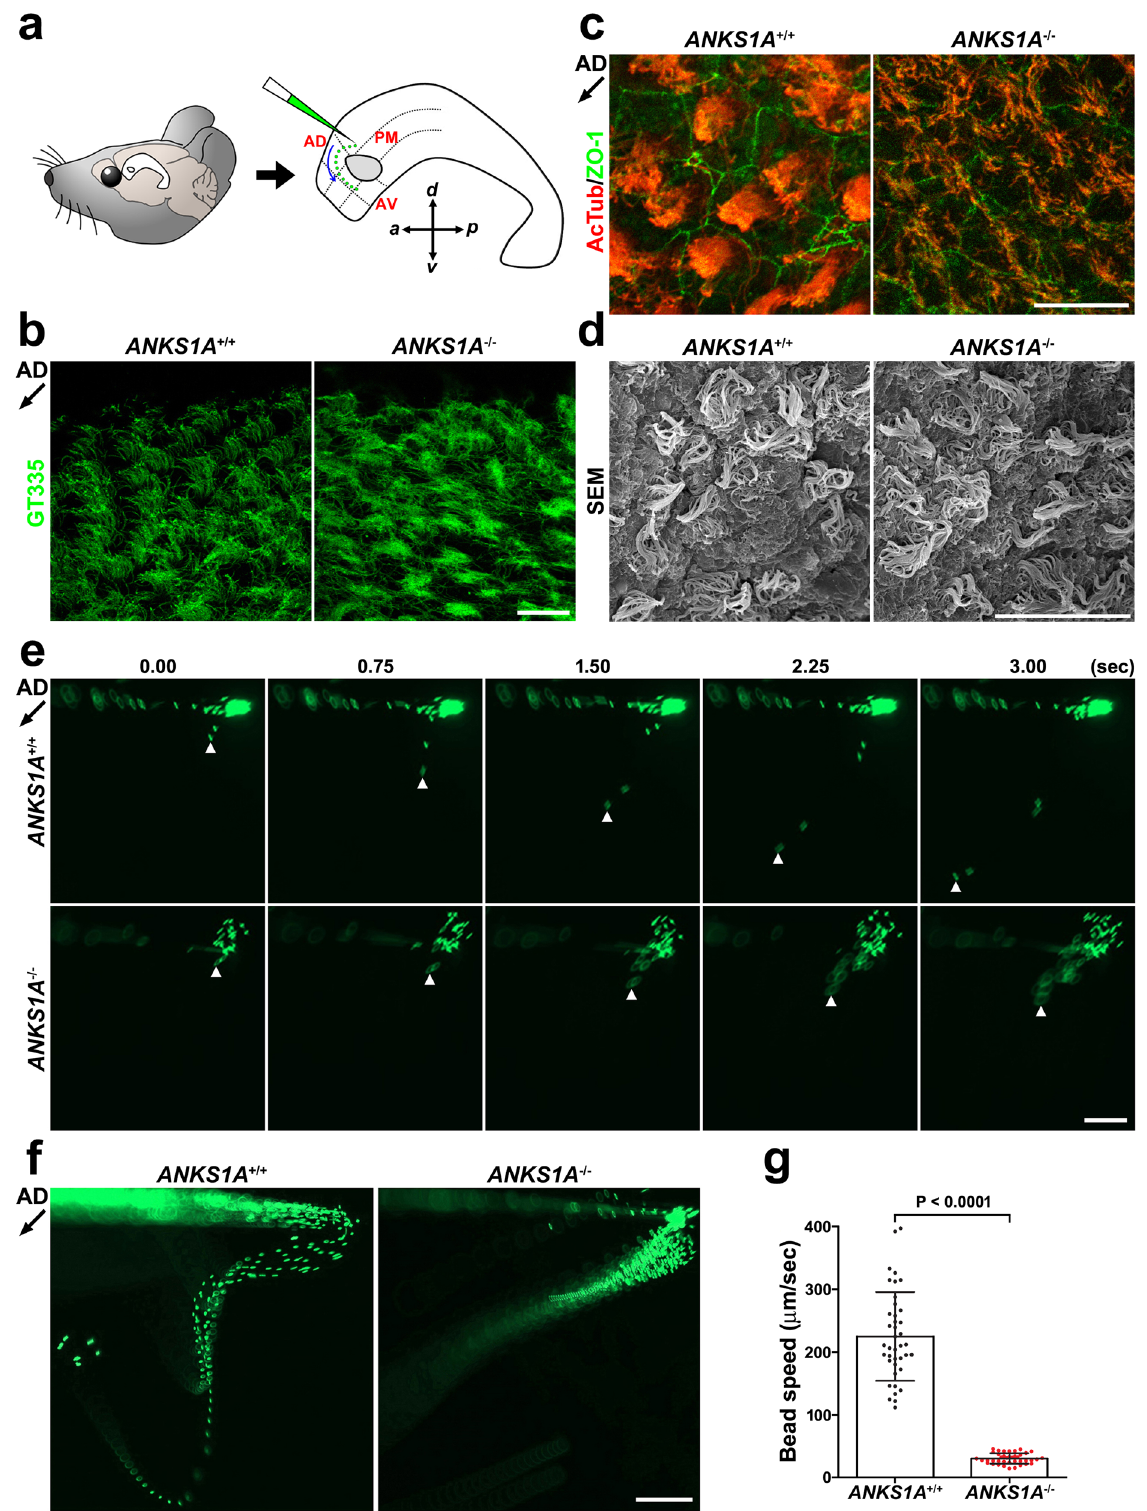
Fig. 3 ANKS1A loss results in uncoordinated beating of motile cilia. a Schematic of LWs showing three regions around the adhesion area (marked by a circle) or the movement of fl uorescent beads (green) on a live LW. AD anterior – dorsal, AV anterior – ventral, PM posterior – medial. b , c Whole-mount staining of LWs using GT335 (glutamylated tubulin) or AcTub (acetylated tubulin) antibodies at P20. The black arrow (~225°) indicates the direction of CSF fl ow in the AD region. The abnormal phenotype of KO ependymal cilia was observed from at least fi ve different pairs of WT and KO littermates. Scale bar for b, c, 20 μ m. d SEM analysis of LWs from littermates at P30. Scale bar, 20 μ m. This result was reproducibly observed from at least three different pairs of WT and KO littermates. e High-speed video imaging analysis of the same fl uorescent bead at different time points. f Thirty- fi ve consecutive frames of Supplementary Movie 1 were merged into a single picture. Scale bar for e , f , 200 μ m. g Data presented in d were used to calculate an average bead speed based on at least three independent experiments. Data represent mean ± S.D. Each point on the graph represents the speed of an individual